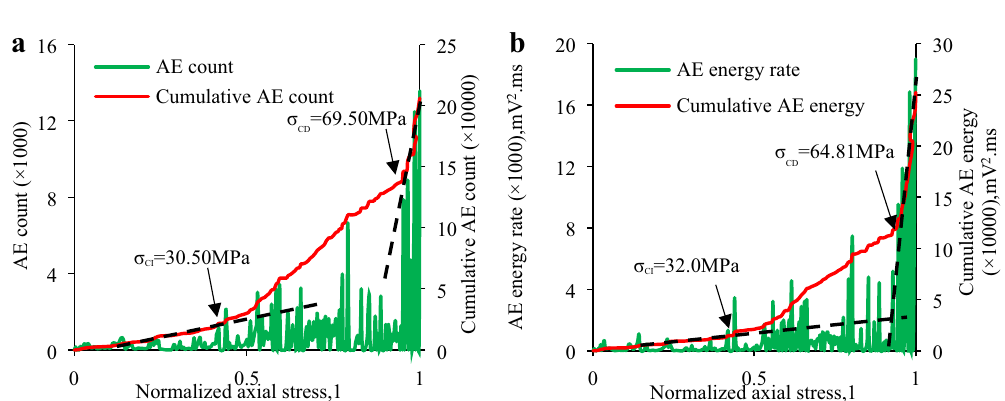
Figure 11. CI and CD thresholds of granite specimen in Test Case 3–3 ( θ = 10°) determined by AE energy and AE count: ( a ) CI and CD thresholds determined by AE count; ( b ) CI and CD thresholds determined by AE